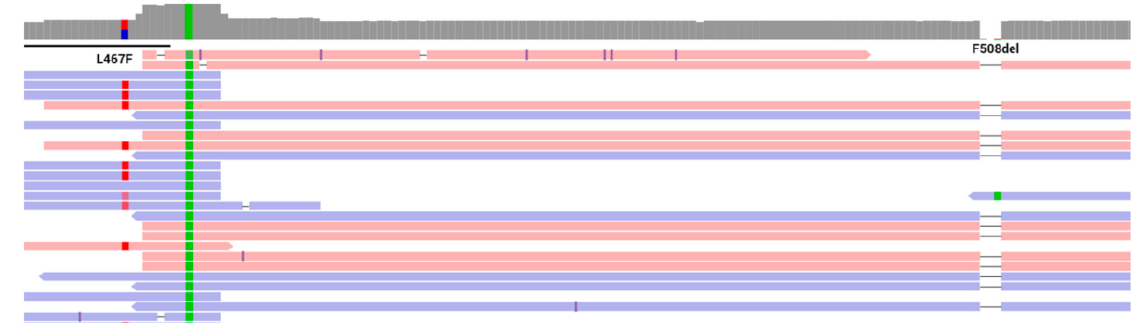
Figure 3. Variants L467F and F508del identified in the patient by mass-parallel sequencing in a heterozygous and homozygous state,